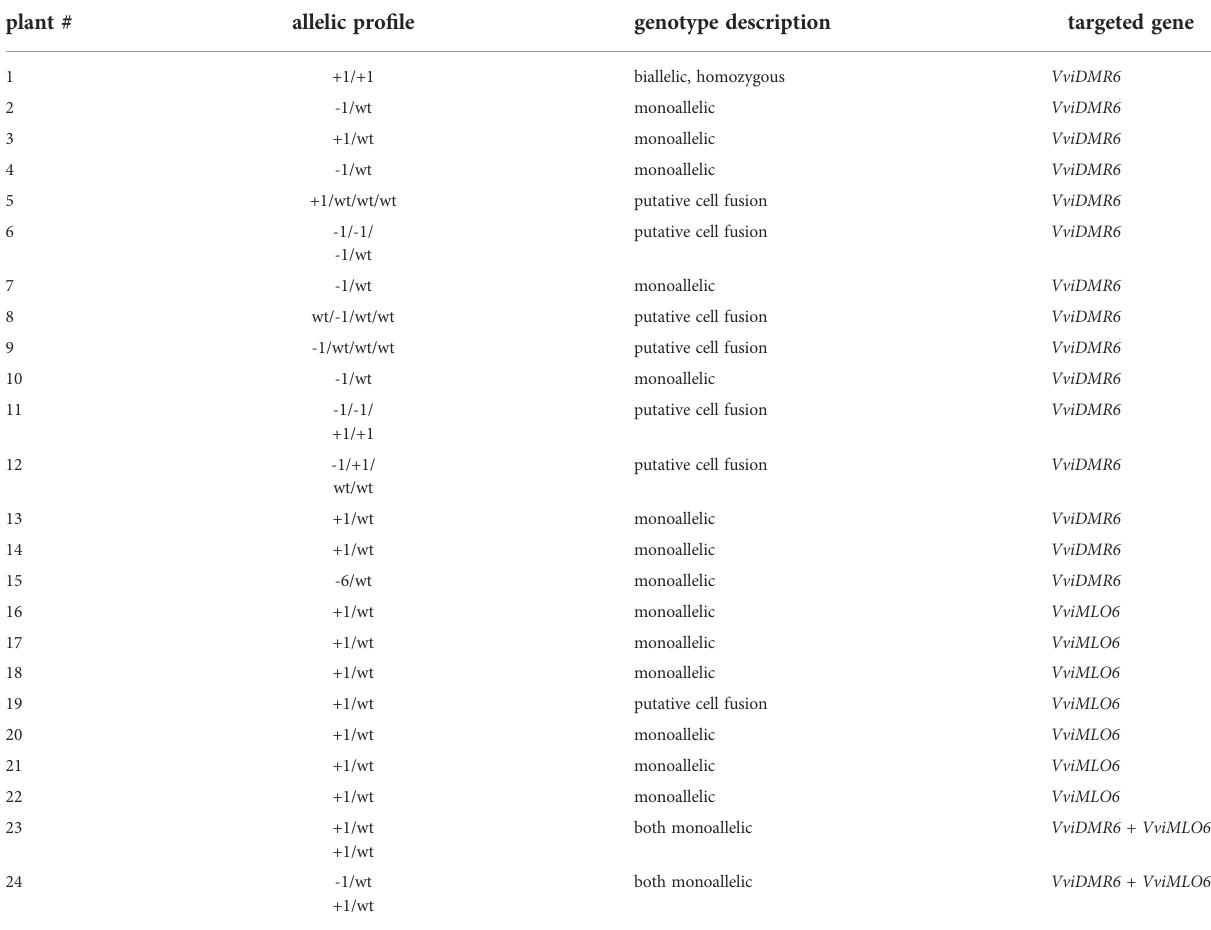
TABLE 4 Allelic pro fi le of the plants regenerated from protoplasts for the cv. Sugraone. Genotyping of Sugraone plants regenerated from